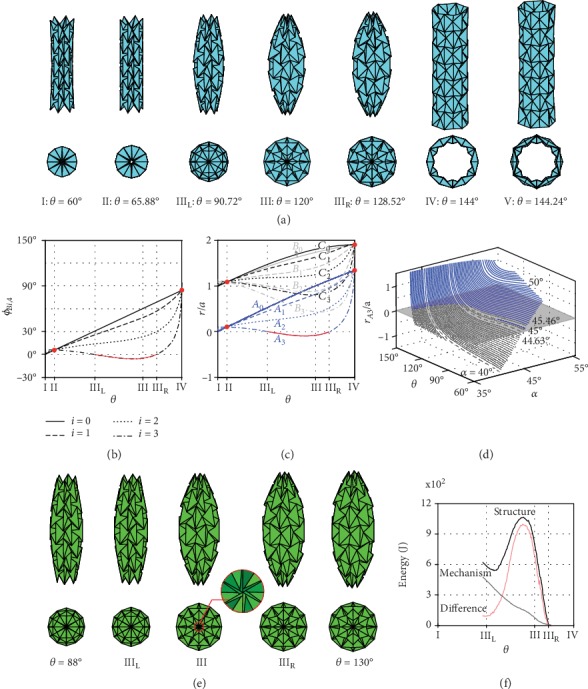
Mechanism-structure-mechanism transition of longer tubes with an odd m. (a) Front and top views of the tube with m = 7, n = 6, and α = 45° deploying from configurations I to V. The corresponding folding angles θ are listed below the deployment sequence. The tube is completely concealed between IIIL and IIIR. Also see SM Movie S2. (b) Variation of dihedral angles ϕBi,4vs. θ. The red curve shows that ϕB3,4 < 0 between IIIL and IIIR. (c) The nondimensional radii r/a of vertices Ai, Bi, and Ci (i = 0, 1, 2, 3) vs.θ, in which the red curve shows rA3 < 0 between IIIL and IIIR. (d) Relationship among nondimensional radius of vertices A3(rA3/a), θ, and α. Some values of α are listed alongside their corresponding curves. The shaded plane is where rA3 = 0. Blue solid lines are for rA3 > 0 and grey dashed lines for rA3 < 0 (where physical interference happens). (e) Front and top views of the waterbomb tube undergoing structural deformation. At configurations IIIR to IIIL, the tube forms a concealed volume. Any in-between configuration, e.g., configuration III, requires structural deformation, as presented in the close up figure where the vertices are squeezed and distorted by each other. (f) Elastic strain energy vs. θ when the tube is modeled as a mechanism (in grey) and as a structure (in black) and their difference (in red).